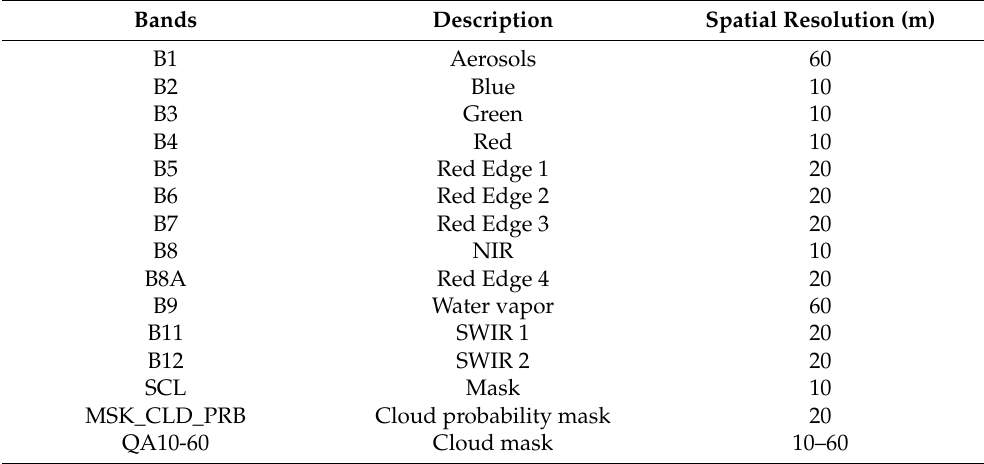
Table 1. A simple overview of the Sentinel-2 surface reflectance product collection composition in the Google Earth